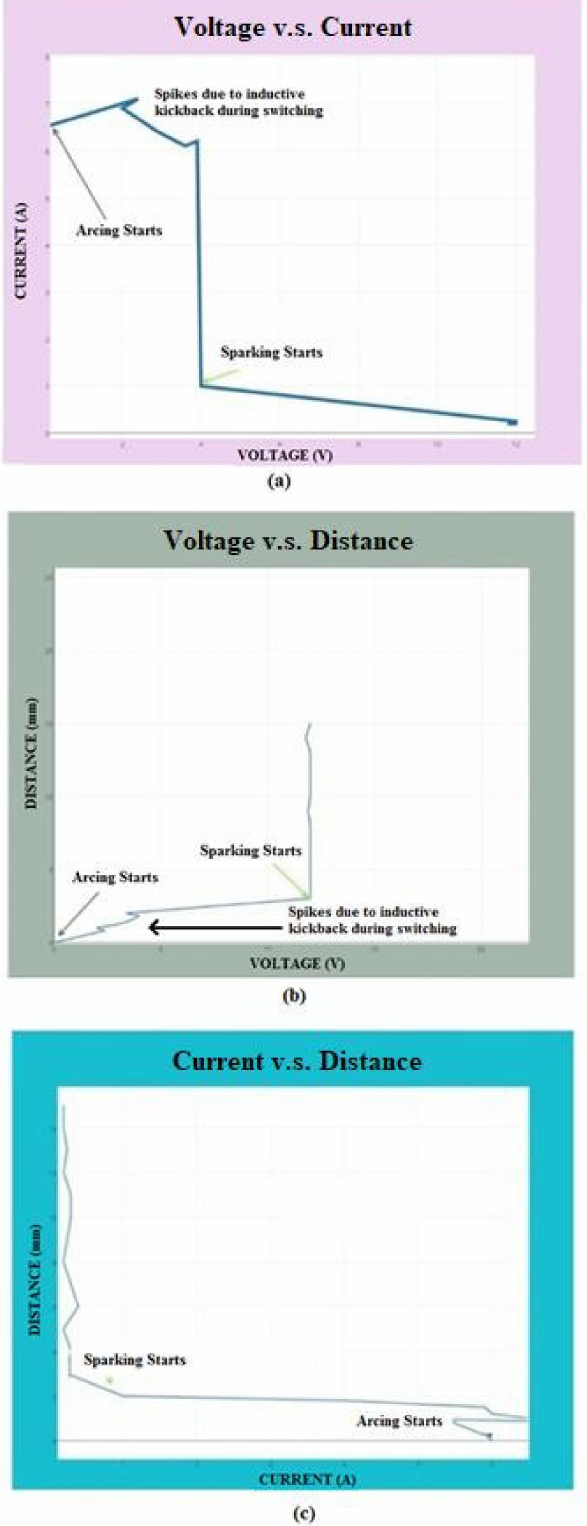
Figure 4. Waveform analysis: ( a ) voltage vs. current, ( b ) voltage vs. distance, ( c ) current vs.